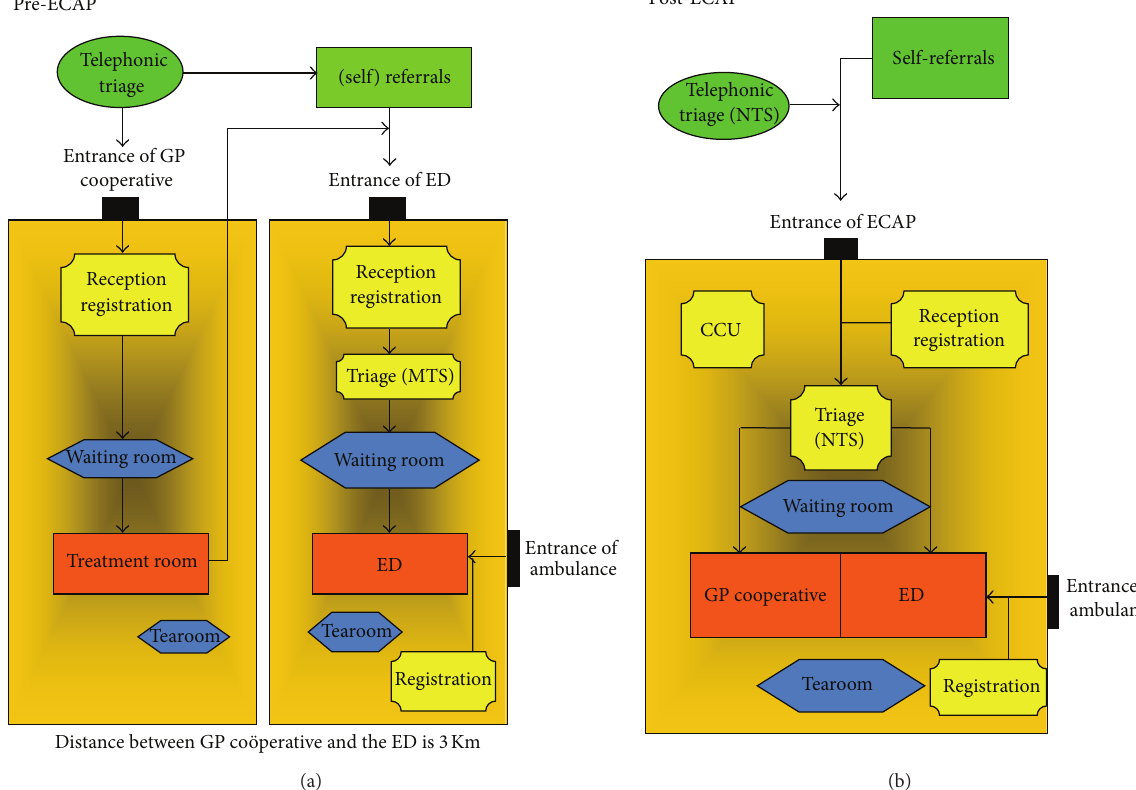
Figure 1: The GP can order blood tests during ECAP hours and order X-rays until 10p.m., without referring the patient to the ED. This is similar to office